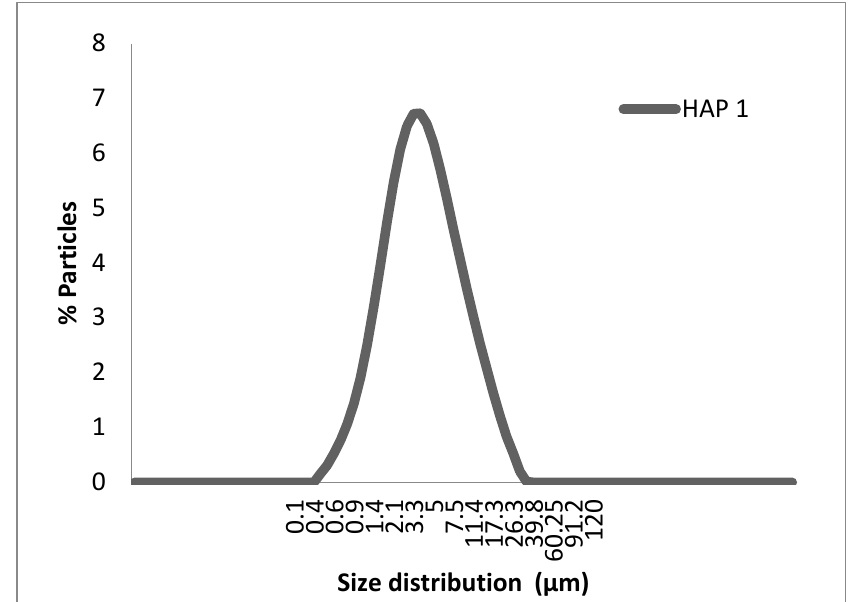
Figure 6. Plot of particle size distribution of the synthesized HAp powder.